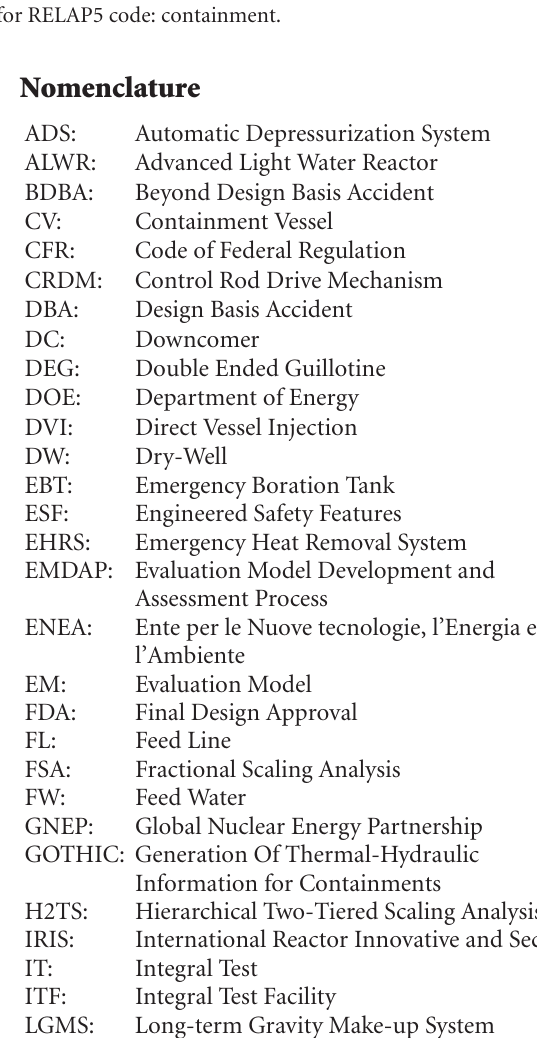
Figure 11: SPES3 nodalization for RELAP5 code: